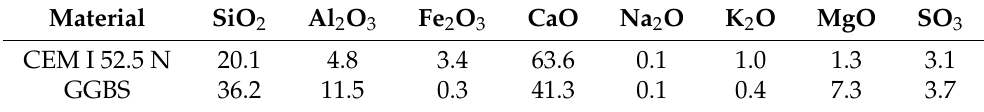
Table 1. Chemical composition of cement and GGBS (%).